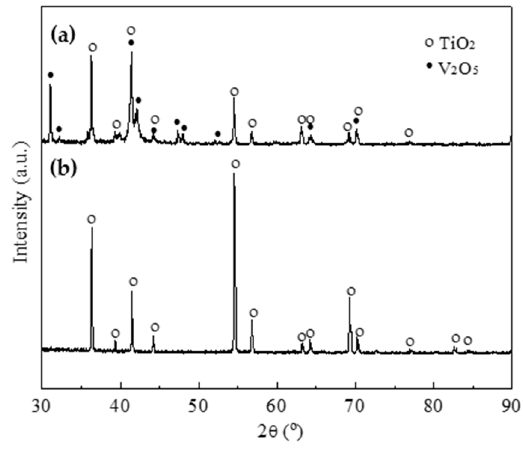
Figure 3. X-ray diffraction (XRD) profiles of TF550 alloy after oxidation at different temperatures for 100 h. ( a ) 873 K and ( b ) 1073 K.